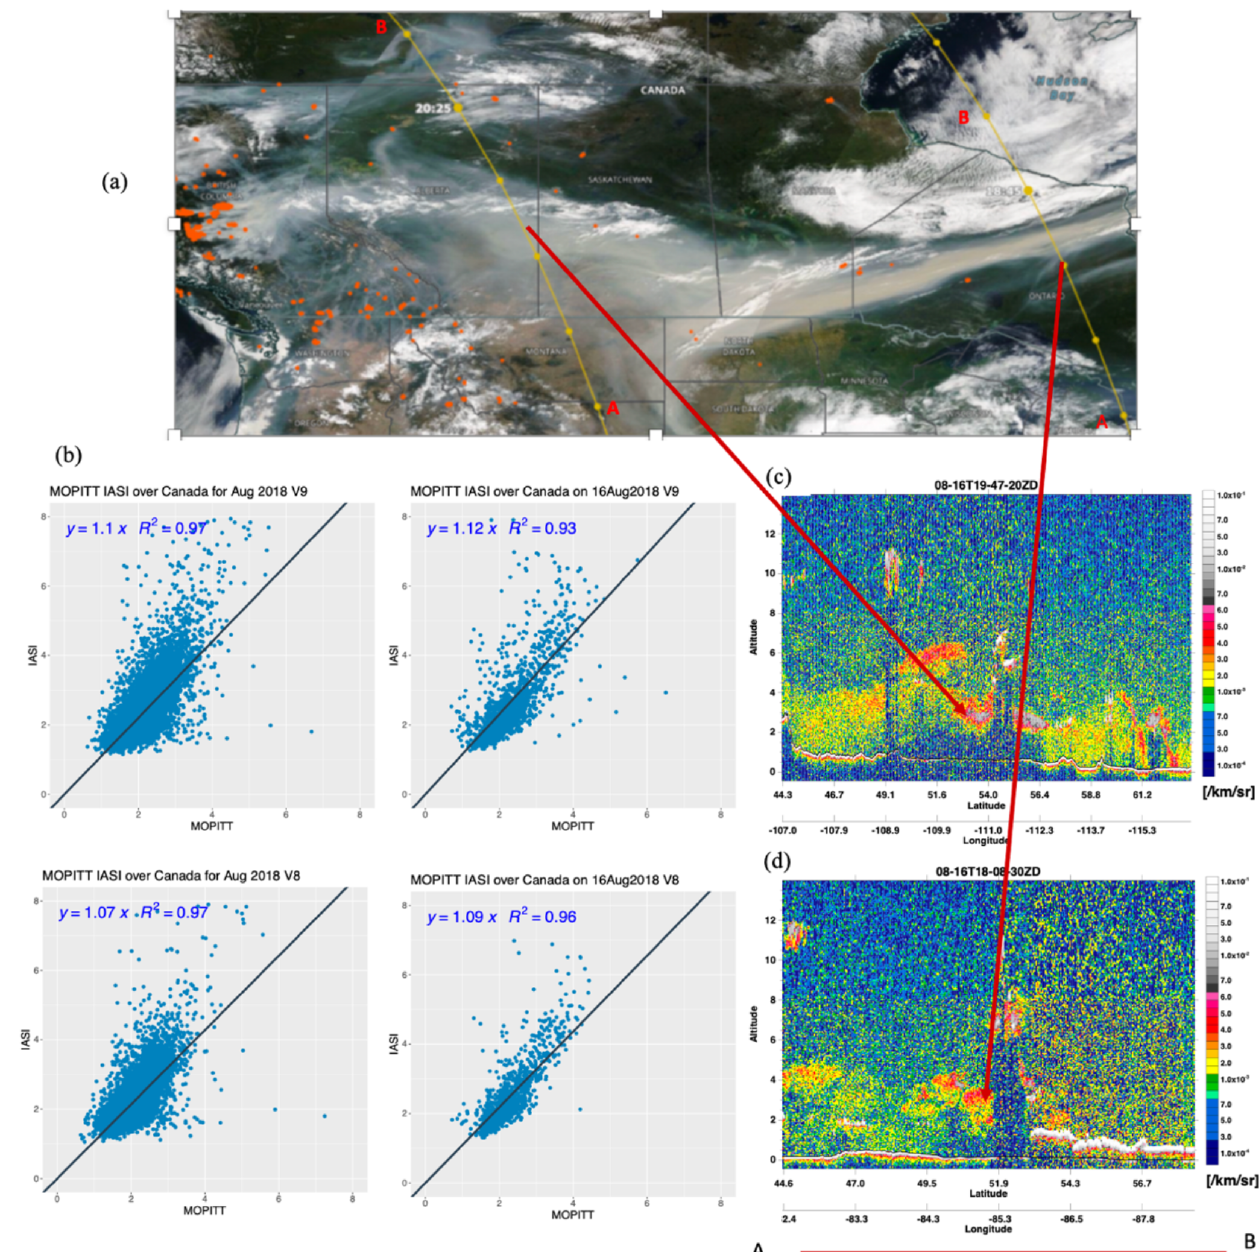
Figure 15. (a) MODIS Terra overlaid with fire points (red points), (b) scatter plots between IASI and MOPITT TIR V9 and V8, and (c– d) daytime CALIPSO 532nm total attenuated backscatter on 16 August